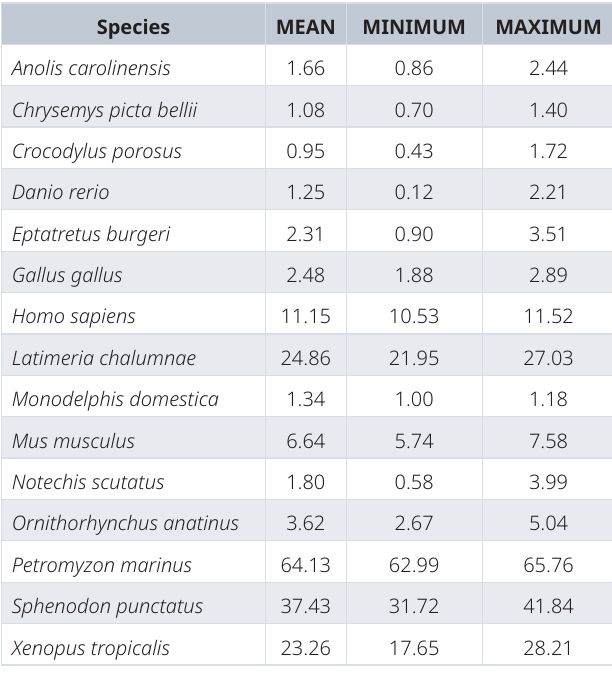
Table 4. Evaluation of RNAmining performance according to different sets of artificial sequences from each trained model. F1-score metrics for 10 datasets of artificial sequences randomly generated for each species. The mean, minimum and maximum values are displayed separated by organism. Other metrics (sensitivity, specificity, precision, accuracy and the confusion matrix) used for the comparisons were made available at the Extended data: Supplementary File S4 19